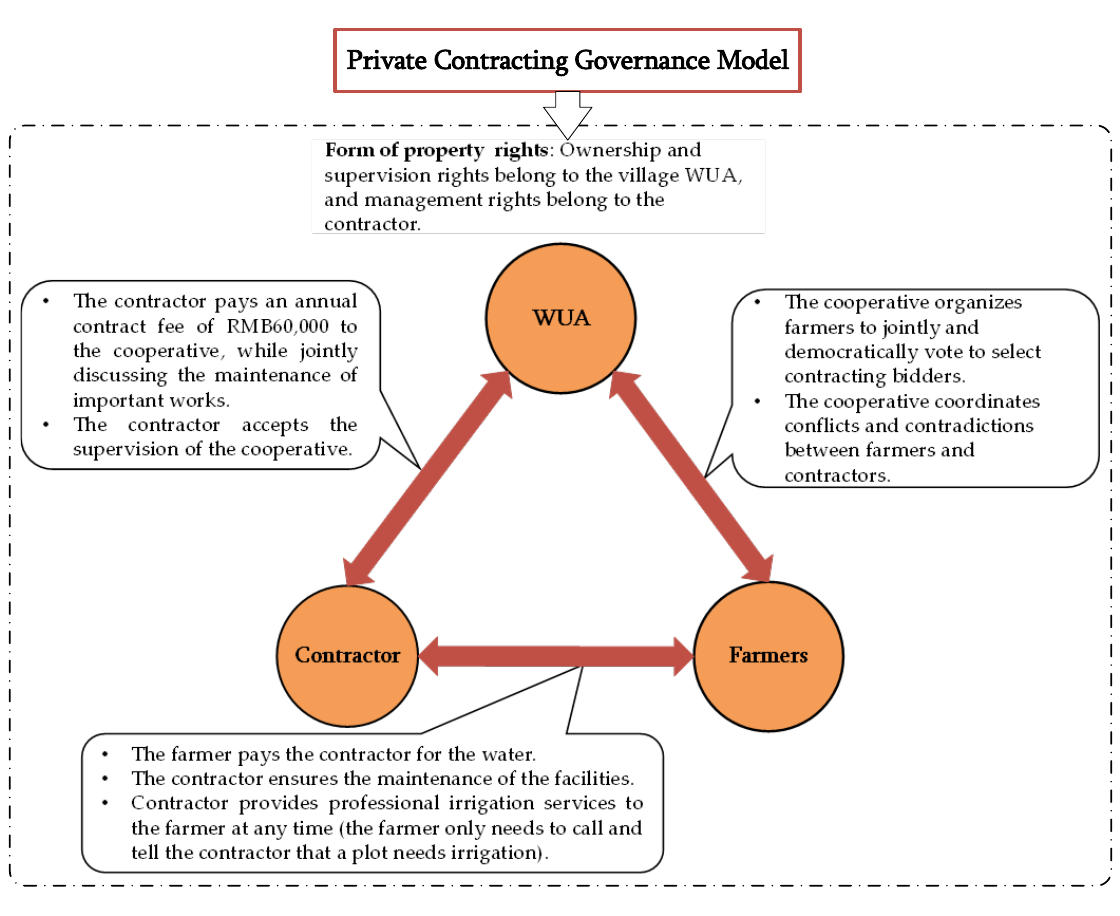
Figure 3. Governance logic inherited in the private contracting governance model.